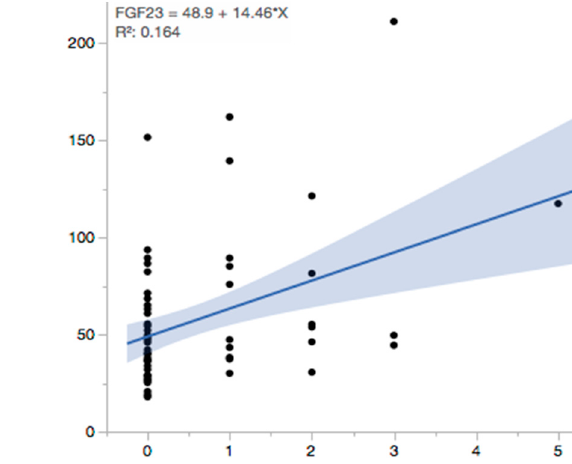
Figure 2. FGF23 levels and correlation with number of exacerbations 12 months after FGF23 sampling. The left panel shows a whisker plot for FGF23 plasma levels in individuals without and with frequent exacerbations that occurred 12 months after sampling for FGF23 measurements. The right panel illustrates the correlation (shaded band representing the 95% confidence interval of the fitted values) between FGF23 plasma levels and number of exacerbations for this time frame.